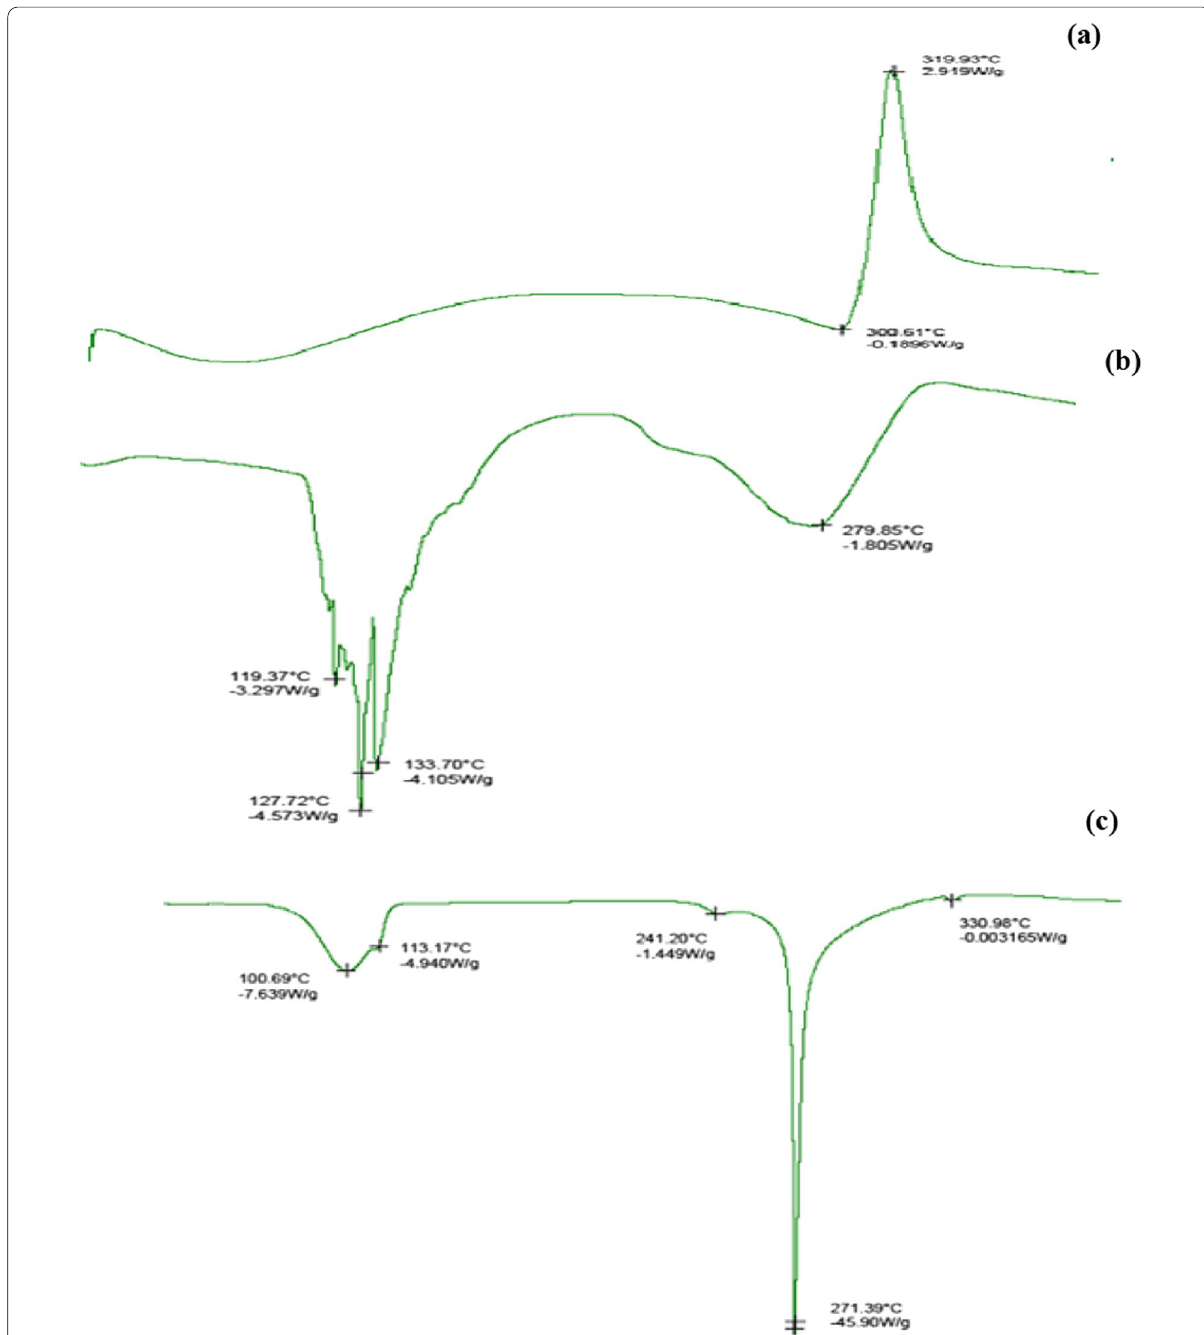
Fig. 3 DSC thermogram of a PLGA, b NPs, c